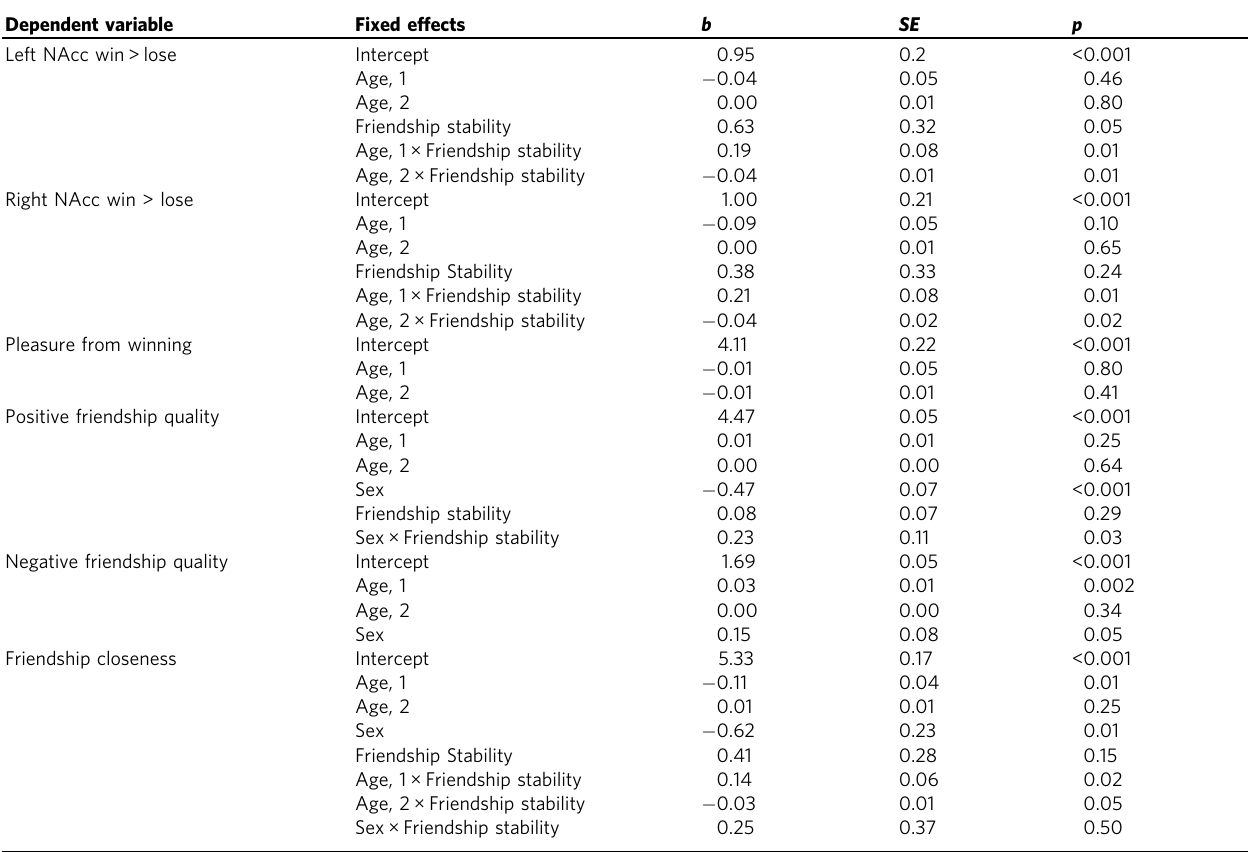
Table 2 Statistical parameters, regression coef fi cients (b), signi fi cance level ( p ) and standard errors ( SE ) for the b s, for the best fi tting mixed-models testing the relation between age and each of the measures reported in the table (two-sided test with α of 0.05). Dependent variable Fixed